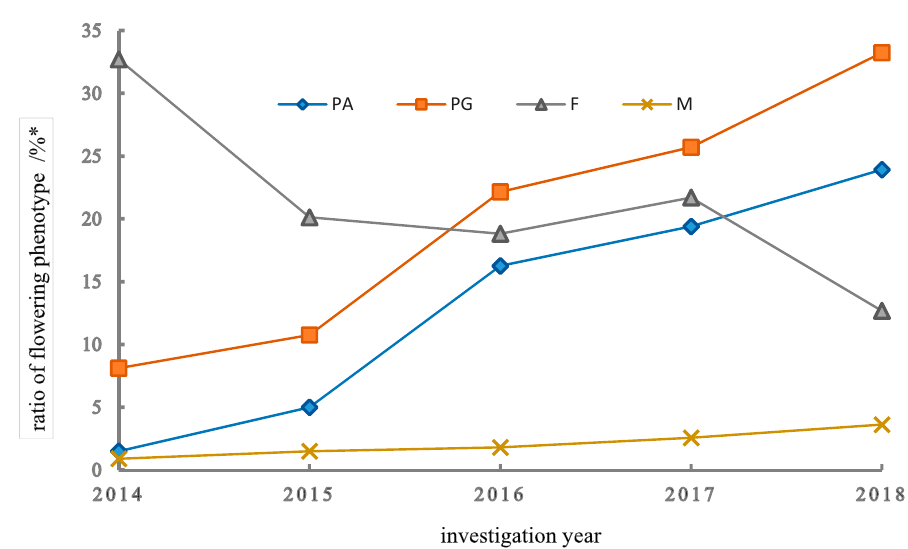
Figure 2. Changing trends of flowering phenotypes with the growth of the C. paliurus population.* Number of each flowering phenotypes / total plants in the population. F: females, M: males.